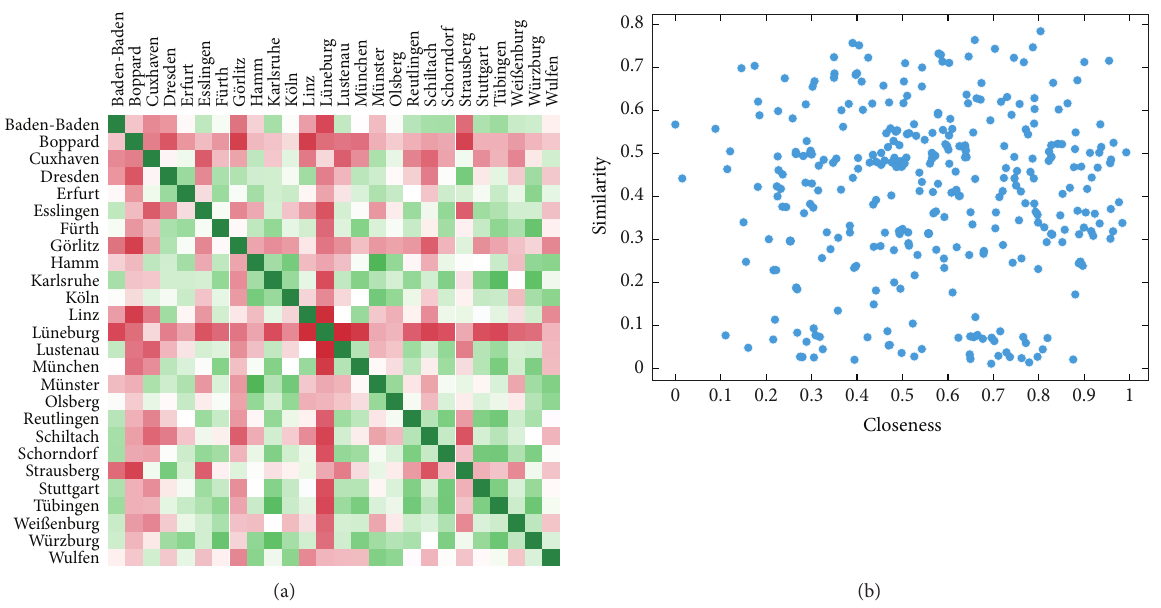
Figure 25: (a) The heatmap of thematic similarity and spatial closeness among city wikis. Red means that the wikis are thematically dissimilar and distant in space; green means that they are thematically similar and close in space. (b): the distribution of the similarities ( y - axis) as a function of the closenesses ( x -axis) of the different pairs of city